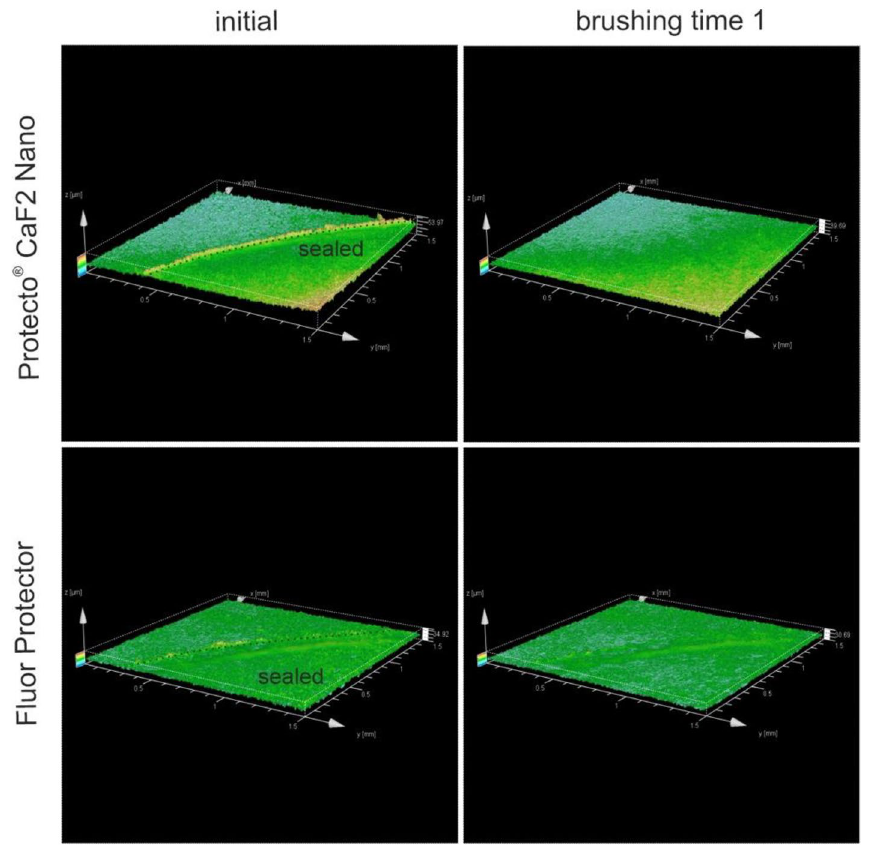
Figure 6. 3D images of the sealants surface topography of ProtectoCaF2 Nano and Fluor Protector determined by optical